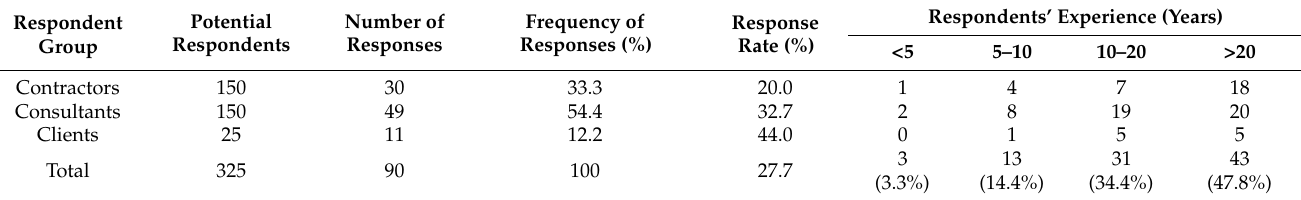
Table 2. Survey response rate distribution by respondent